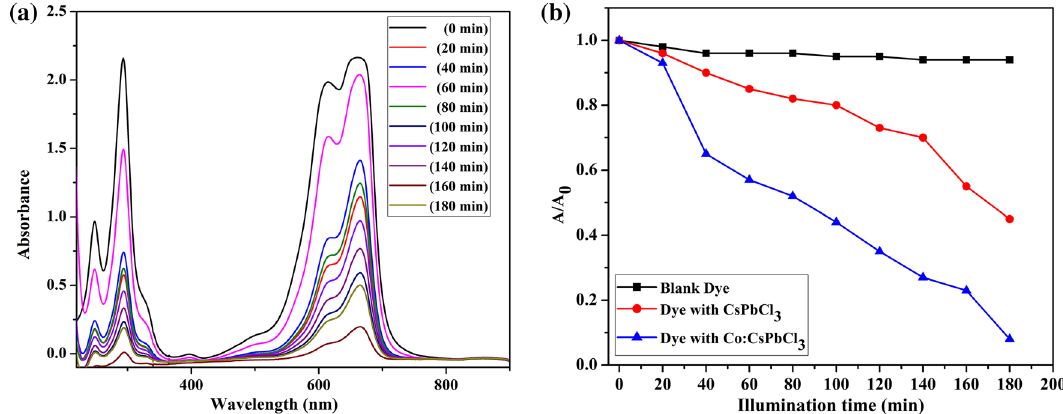
Figure 13. ( a , b ) The effect of UV–Visible spectra of MB and decrease in con. of MB with time respectively.